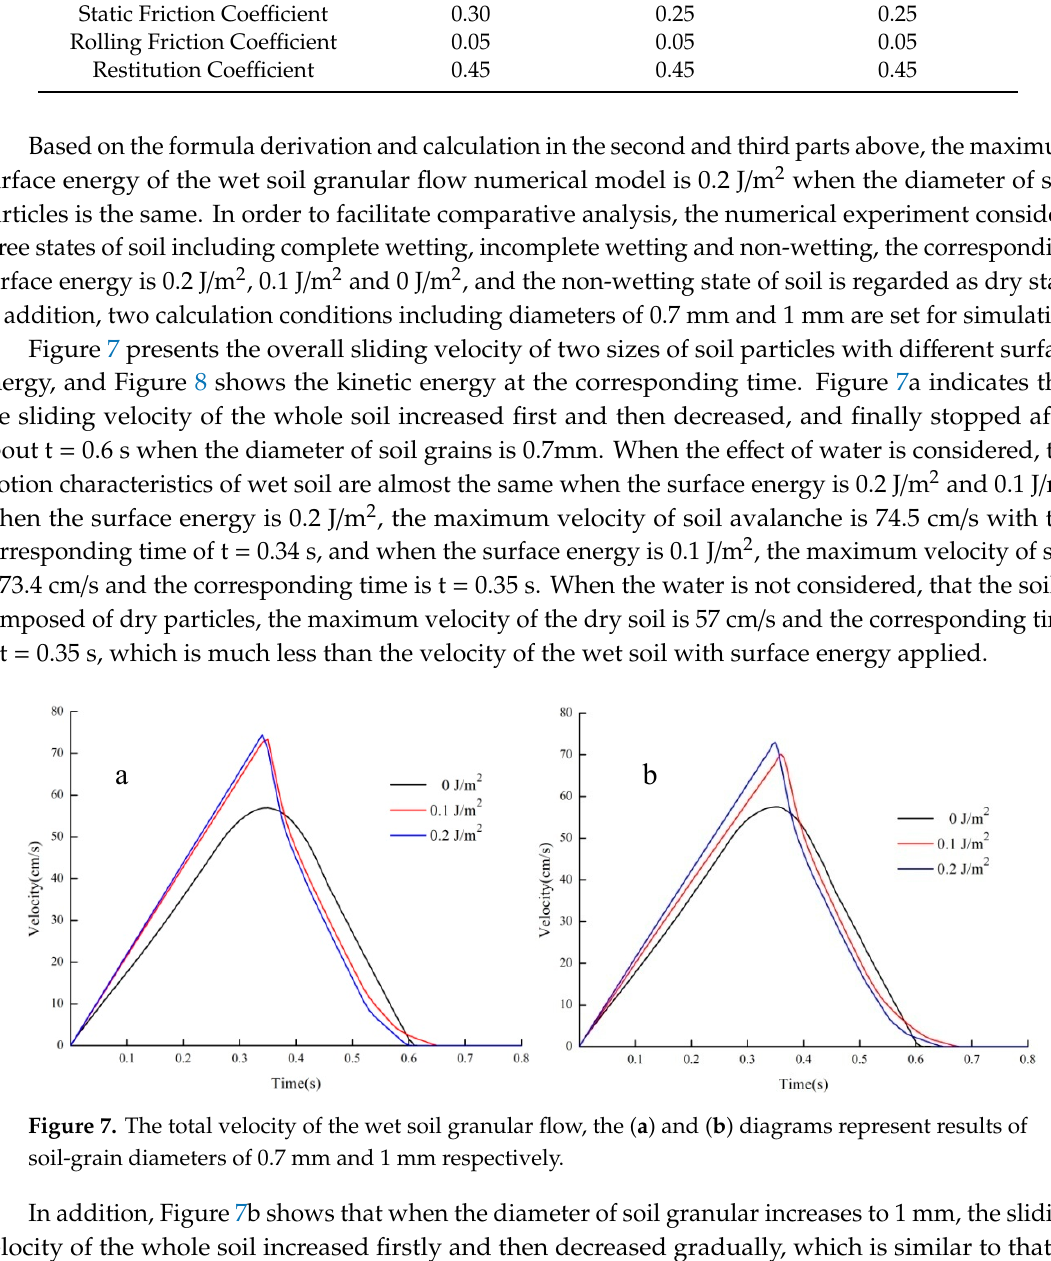
Table 1. Material parameters used in the numerical experiments.